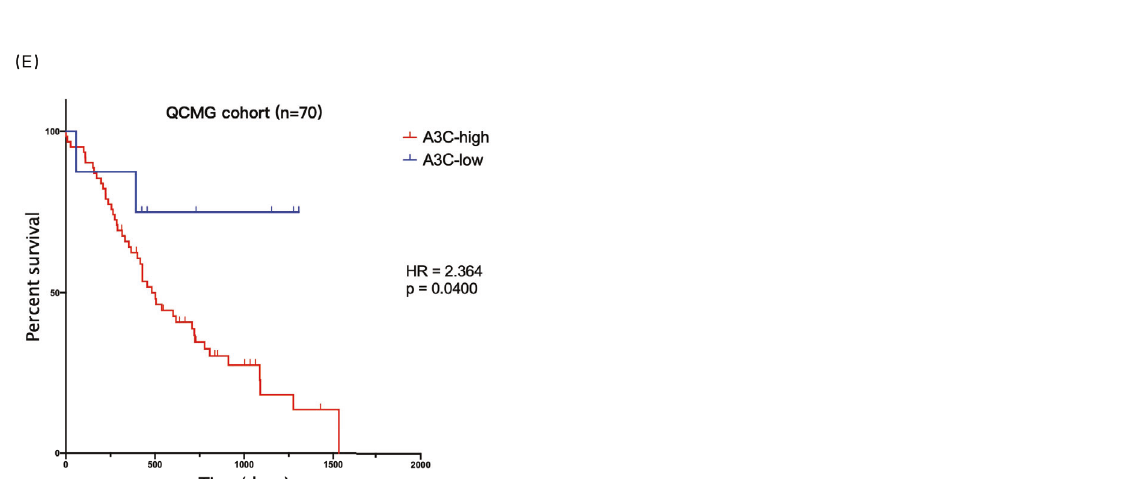
Fig. 5 Universal high APOBEC3C expression in PDAC denotes shorter OS. The Mantel – Cox test was used to compare Kaplan – Meier survival curves. A , B Representative IHC images showing relatively high expression ( A patient ID: 470506) and relatively low expression ( B patient ID: 372428) of APOBEC3C in PDAC tissues. Sixty PDAC specimens (FUSCC cohort B1) underwent IHC staining with an APOBEC3C antibody to corroborate the qRT – PCR results. Positive APOBEC3C staining was located in the nucleus and cytoplasm of pancreatic tumour cells. C A cutoff value of 0.011802837 (qRT – PCR result) strati fi ed the patients in FUSCC cohort B into the high APOBEC3C expression subgroup ( n = 109) and low APOBEC3C expression subgroup ( n = 15) with a difference in OS. The mRNA expression level was determined by performing qRT – PCR with cDNAs in triplicate, and the normalised mean value was used for analysis. D A cutoff value of 353.34 TPM strati fi ed TCGA cohort into the high APOBEC3C expression subgroup ( n = 69) and the low APOBEC3C expression subgroup ( n = 94) with a trend towards a difference in OS. E A cutoff value of 372.77 TPM strati fi ed the QCMG cohort into the high APOBEC3C expression subgroup ( n = 62) and the low APOBEC3C expression subgroup ( n = 8) with a difference in OS. PDAC, pancreatic ductal adenocarcinoma; A3C, APOBEC3C; HR, hazard